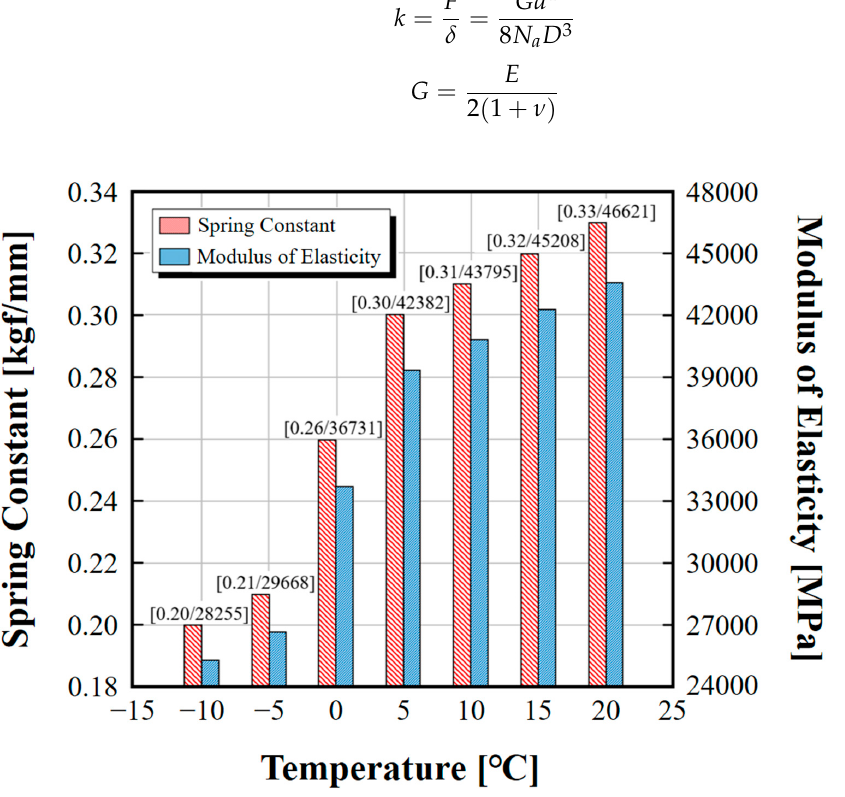
Figure 6. Results of spring loading test. Table 3. Deflection of SMA coil springs according to